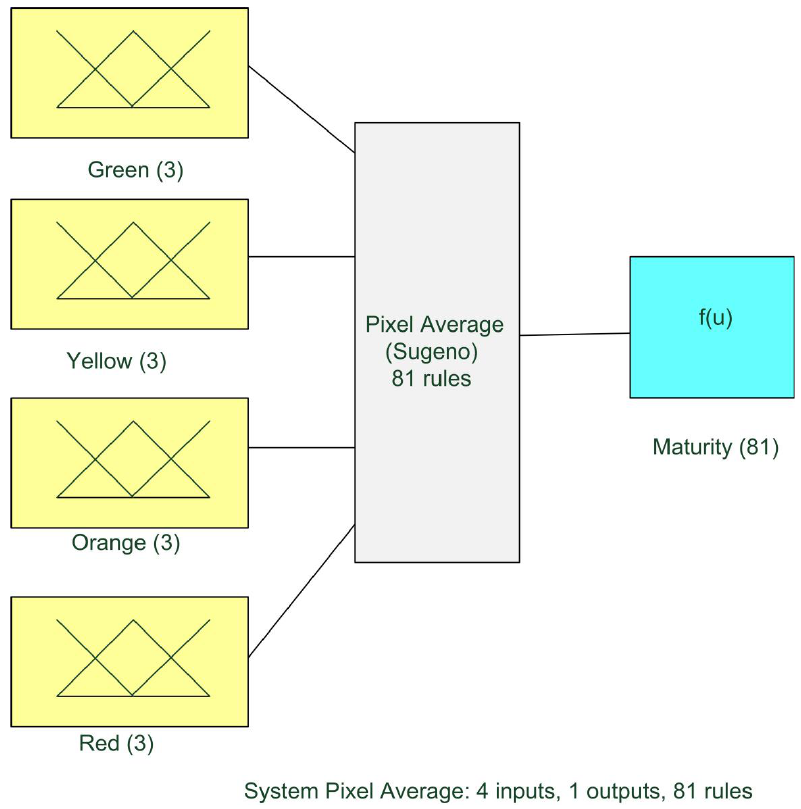
Figure 10 Figure 10. Fuzzy maturity